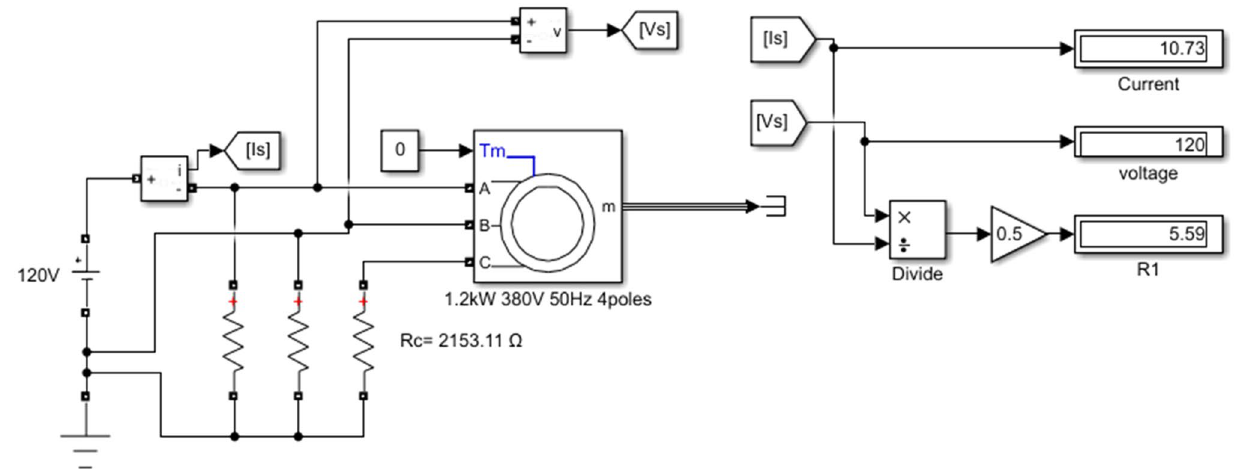
Fig. 2 DC test to determine stator resistance